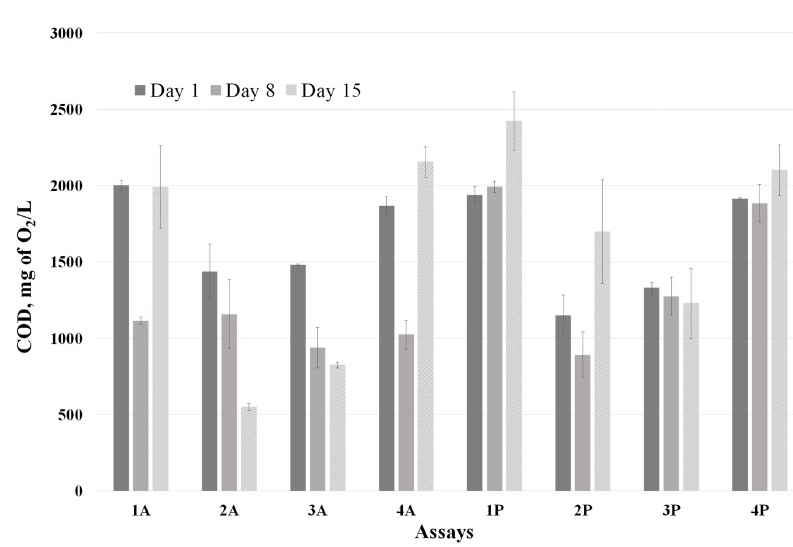
Figure 1 - Chemical oxygen demand (COD) for the tests of treating industrial textile waste with leachate and nutritional enrichment, under more (A) and less (P) intense agitation, with the addition of molasses ( 1 ), vinasse in lower ( 2 ) and in higher ( 3 ) concentrations, and 50/50 molasses/vinasse ( 4)